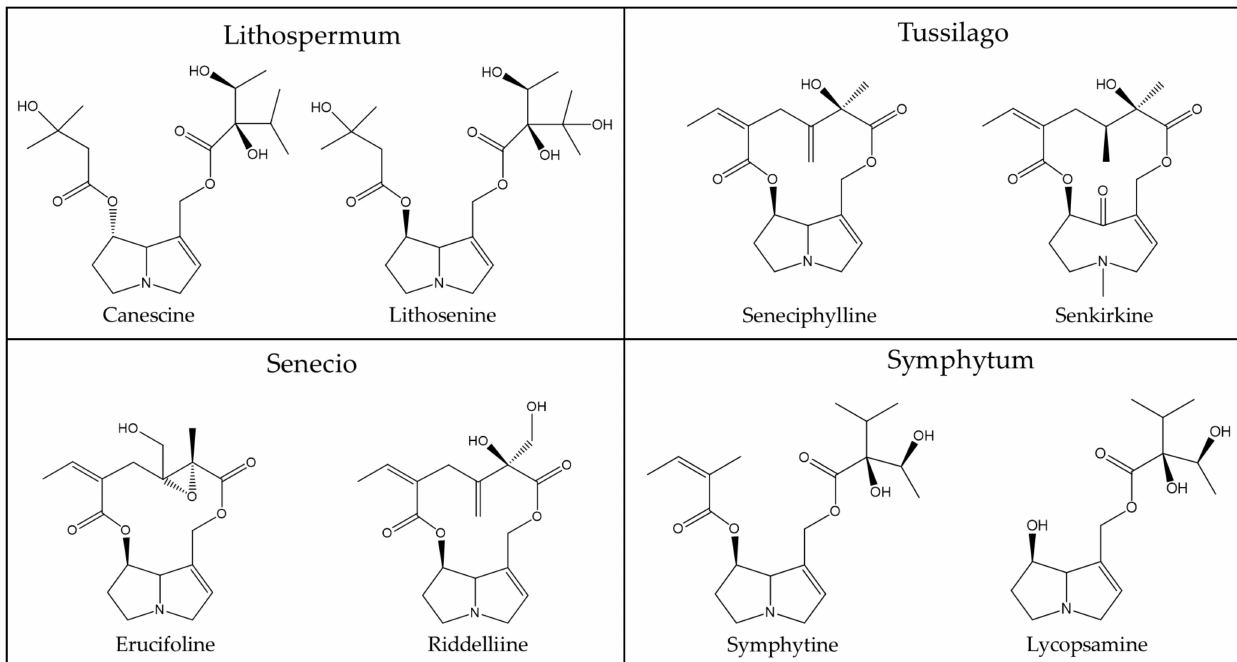
Figure 4. Examples of pyrrolizidine alkaloids inherent in plants of the genera Lithospermum , Tussilago , Senecio , and Symphytum . The figures with these chemical structures were obtained from the open access report of Kopp et al.